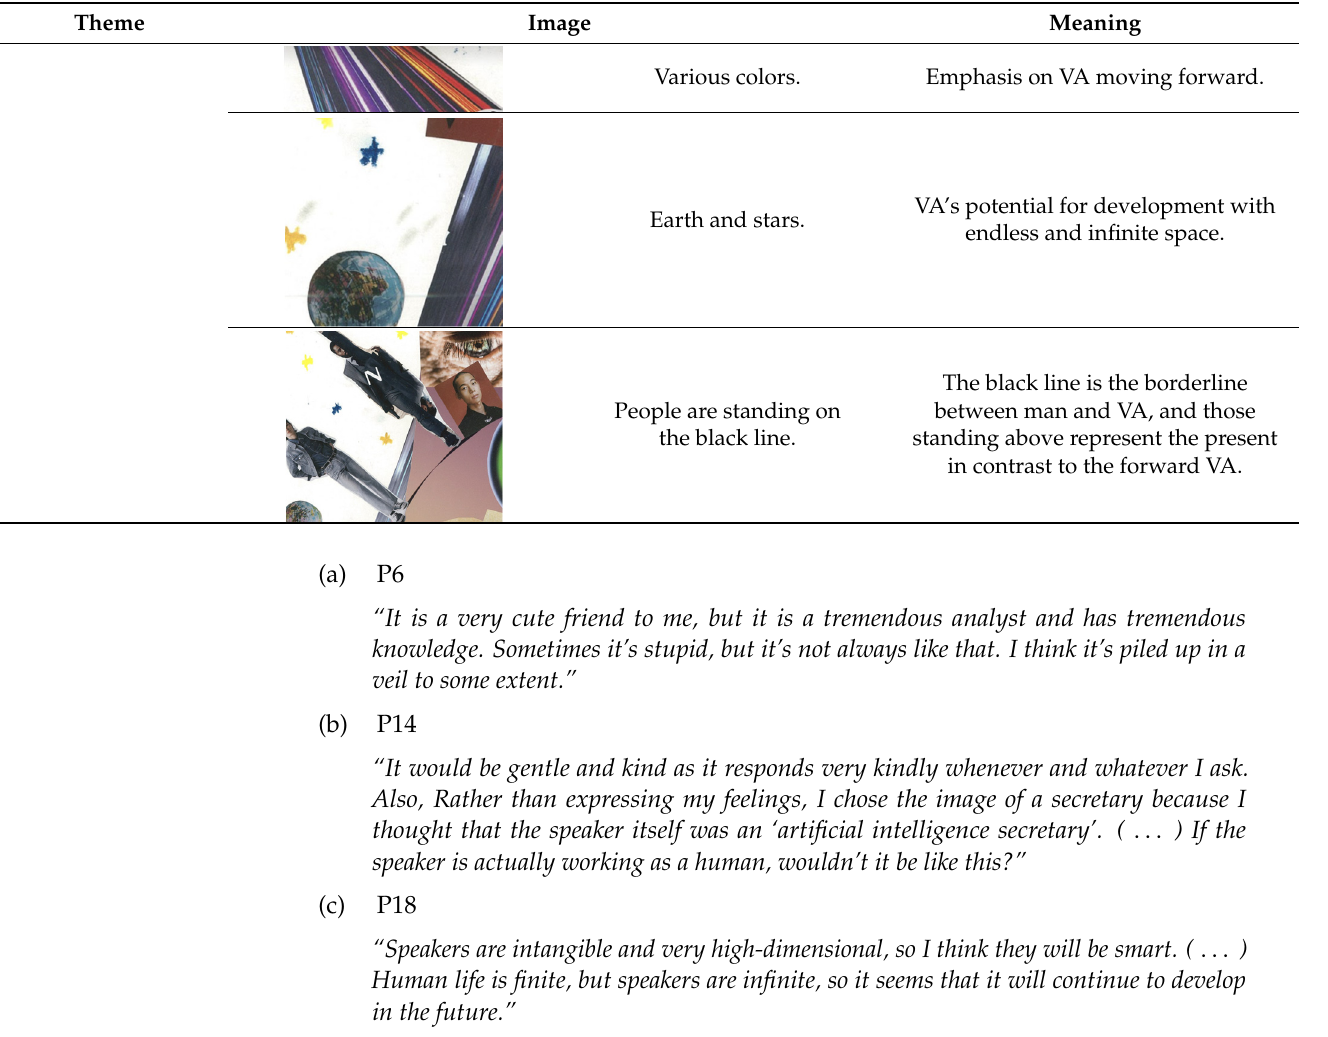
Table 3. Cont. Image Various colors. Emphasis on VA moving forward. Various colors. Emphasis on VA moving forward. VA’s potential for development with end- Earth and stars. less and infinite space. VA’s potential for development with end- VA’s potential for development with Earth and stars. Earth and stars. endless and infinite space. less and infinite space.